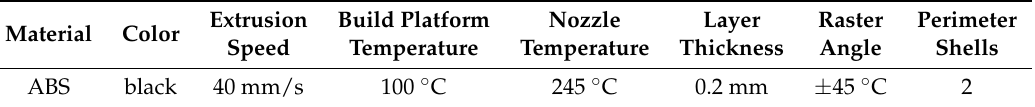
Table 1. Used process parameters for the manufacturing of the test